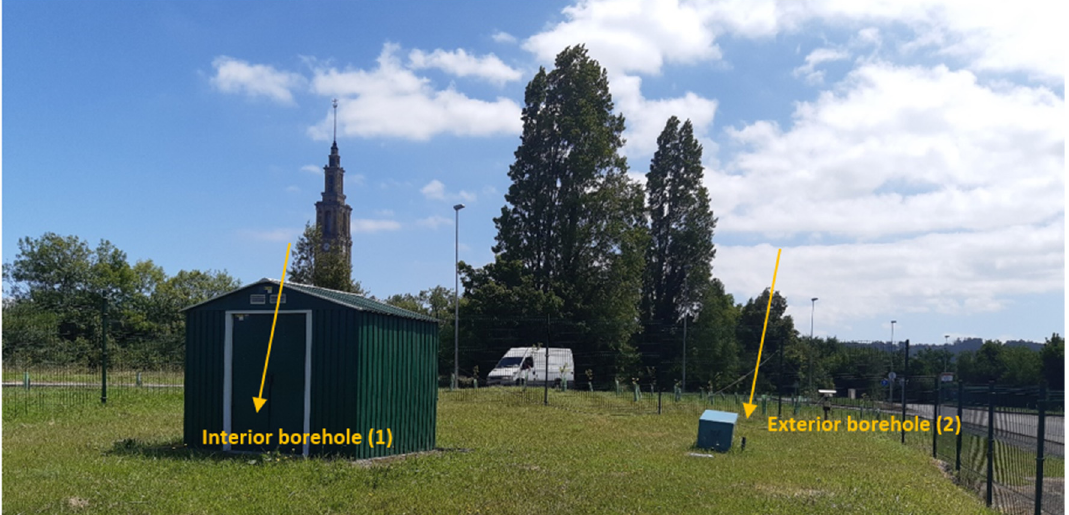
Figure 2. Location of the Q-Thermie-uniovi research boreholes at the Campus of Viesques (Gijón, Asturias).